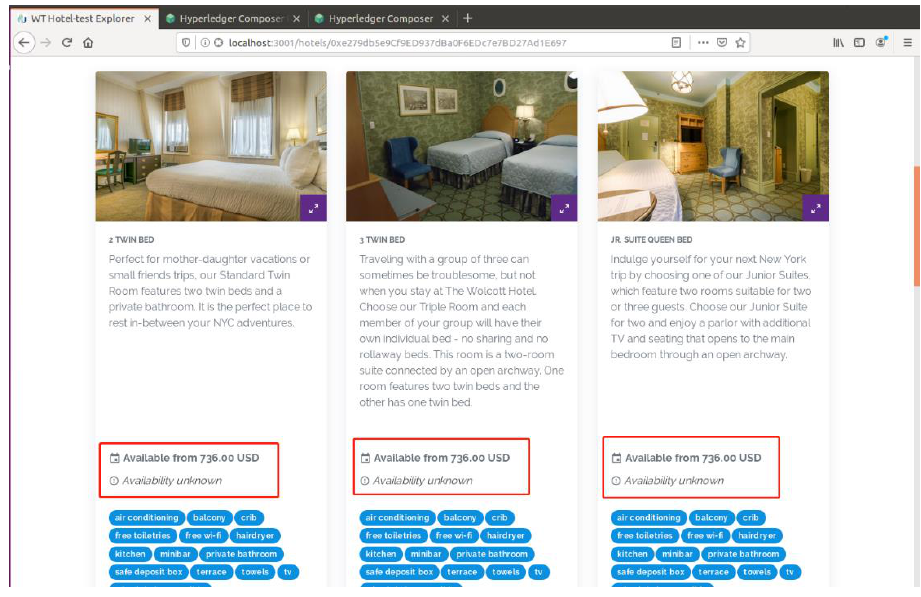
Figure 26. The client search results.